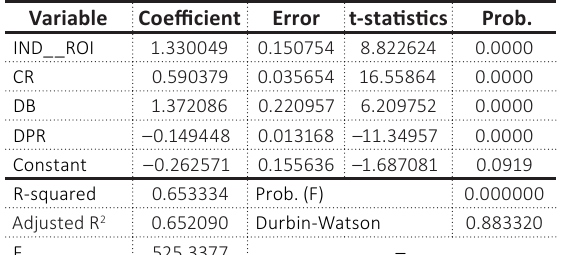
Table 7. First model